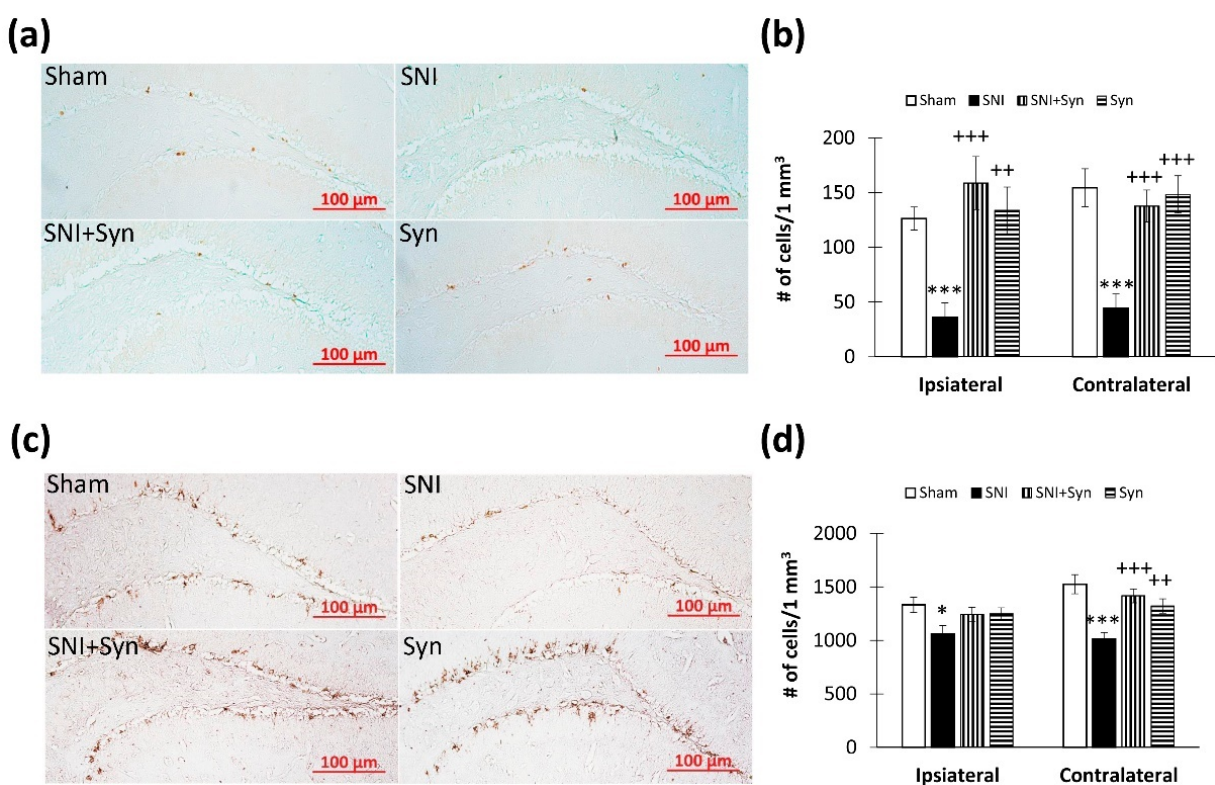
Figure 6. Hippocampal neurogenesis in SNI and synaptamide treatment. ( a ) Representative images of PCNA-positive cells in DG SGZ. ( b ) The number of PCNA-positive cells in DG SGZ. Scale bar—100 µ m. ( c ) Representative images of DCX-positive cells in DG SGZ. ( d ) The percentage of DCX-immunopositive staining area in DG SGZ. Scale bar—100 µ m. Two-way ANOVA with post hoc Tukey test, * p < 0.05, ** p < 0.01, *** p < 0.001; + p < 0.05, ++ p < 0.01, +++ p < 0.001. *-compared to Veh, + -compared to LPS.